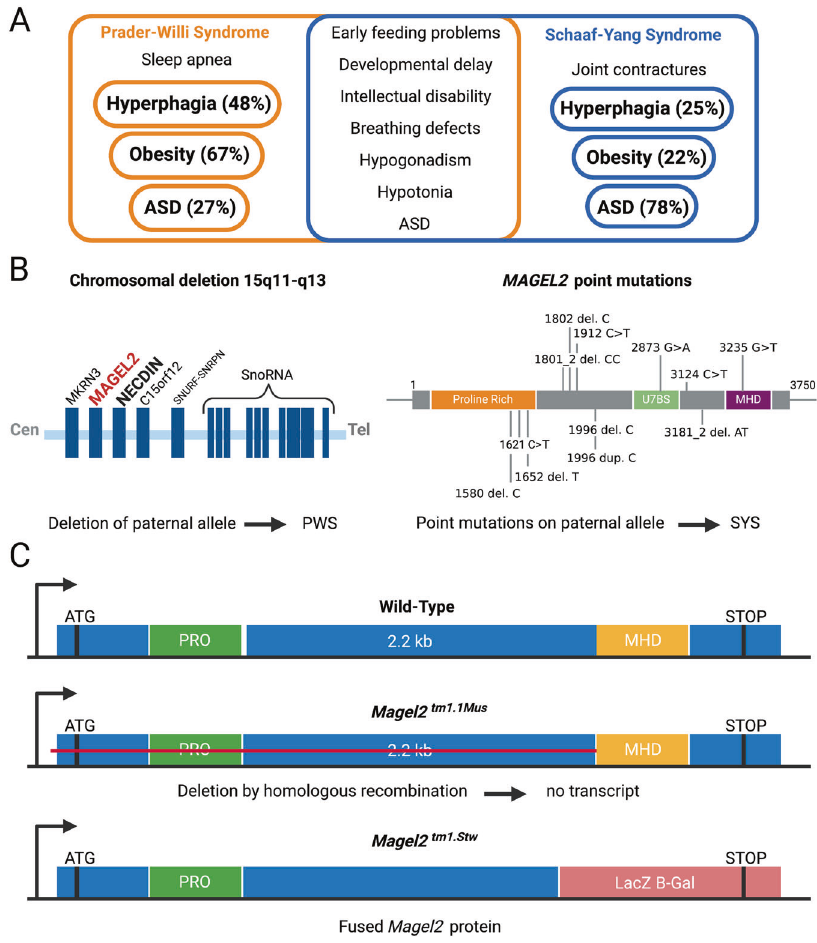
Fig. 1 Genetic causes and transgenic mouse models of PWS and SYS. A Overview of common and distinct symptoms in PWS and SYS patients, as per [76]. B Genetic causes for PWS and SYS. Deletion of MAGEL2 on the paternal allele causes PWS, while various point mutations within the MAGEL2 gene are the cause of SYS. C Differences in the two transgenic Magel2 KO mouse models. In the Magel2 tm1.1Mus mouse, no transcript is produced due to the deletion of the gene by homologous recombination. In the Magel2 tm1.Stw mouse, insertion of the LacZ B-Gal gene results in the expression of a fused Magel2